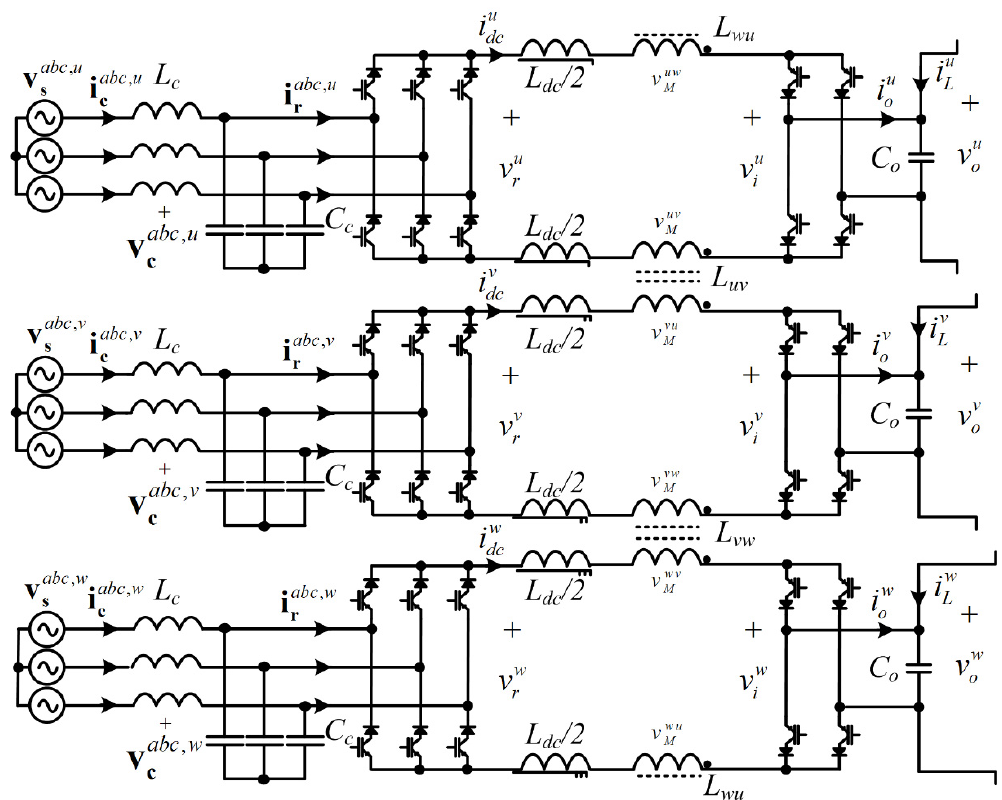
Figure 2. Three cells magnetically coupled by their DC links.